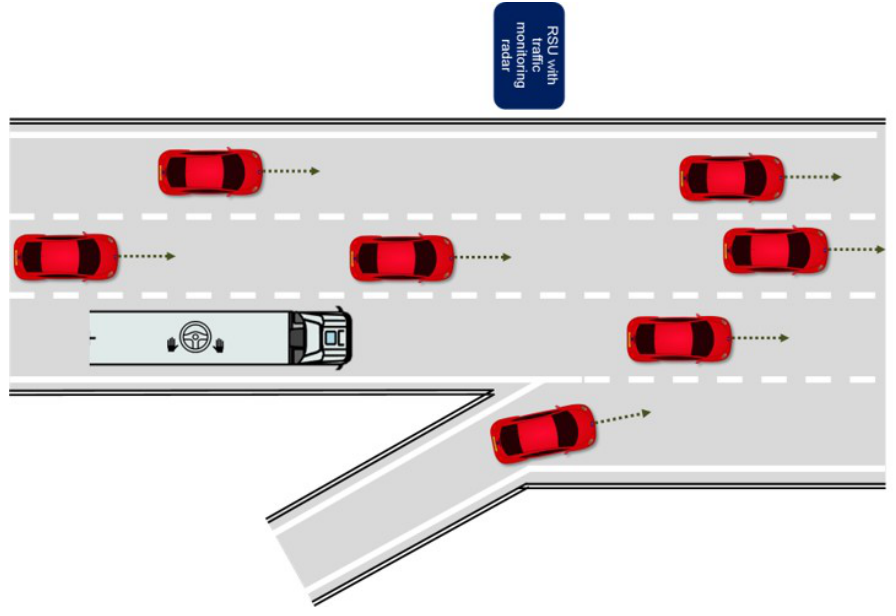
Figure 6. PRoPART use